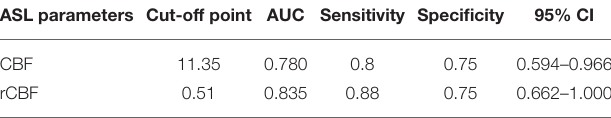
TABLE 2 | ROC analysis of ASL parameters for the differential diagnosis between medulloblastoma and pilocytic astrocytoma. ASL parameters Cut-off point AUC Sensitivity